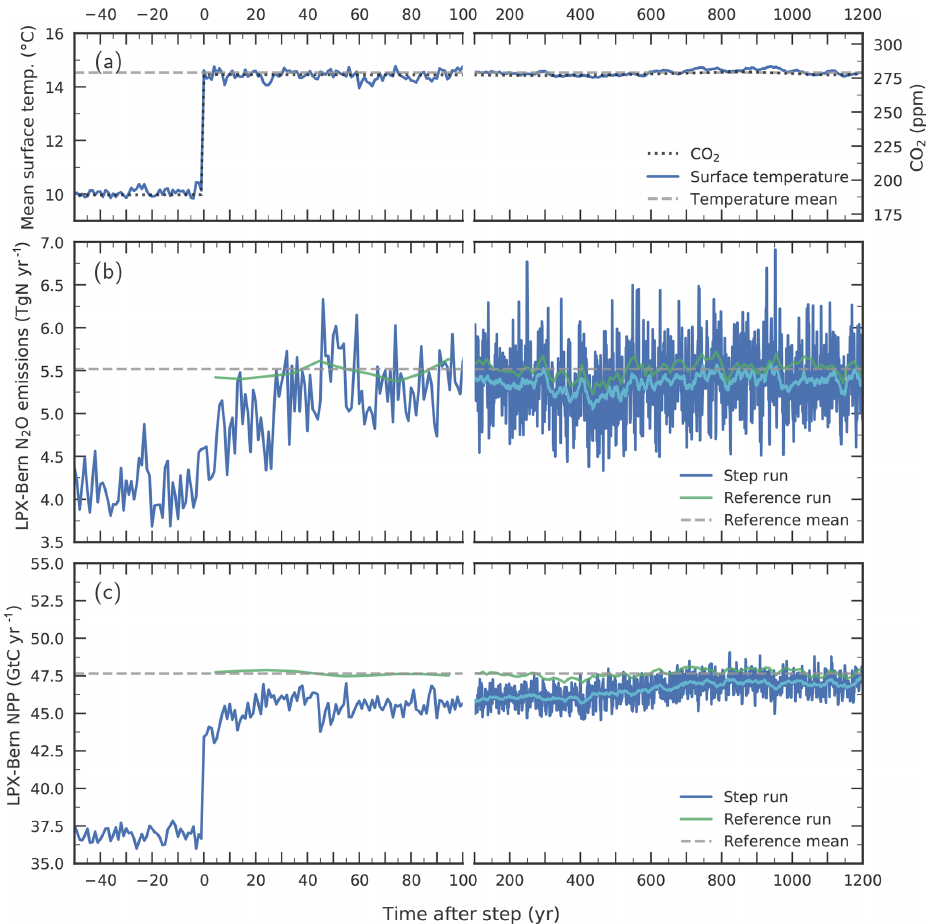
Figure 11. Response to a step-like change in (a) environmental conditions for globally averaged terrestrial (b) N 2 O emissions and (c) NPP. Atmospheric CO 2 (dotted line in a ) and climate are prescribed to suddenly change from Last Glacial Maximum conditions to late Holocene conditions in a sensitivity simulation with LPX-Bern(v1.4N) (“step run”, blue lines). Annual values for the step run are shown in dark blue and smoothed (31-year average) values in light blue for the step run and in dark green for a corresponding reference run. The dashed horizontal lines represent averages from the reference run over the model period 0 to 1200 years. Surface air temperature in (a) represents the average over the model’s land area. Note the change in the time-axis scaling at year